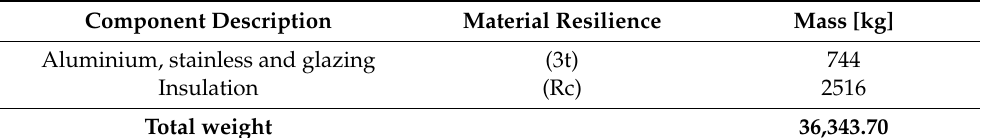
Table 4. Insulation and glazing materials used in the L3 case study by mass (kg) and their resilience metric. 3t = reusable up to three times, and Rc =